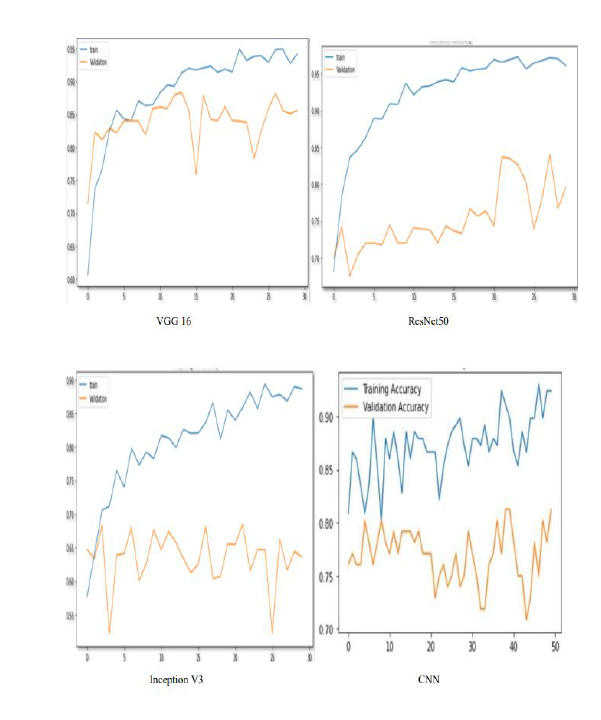
Figure 5. Accuracy graphs of di ↵ erent models